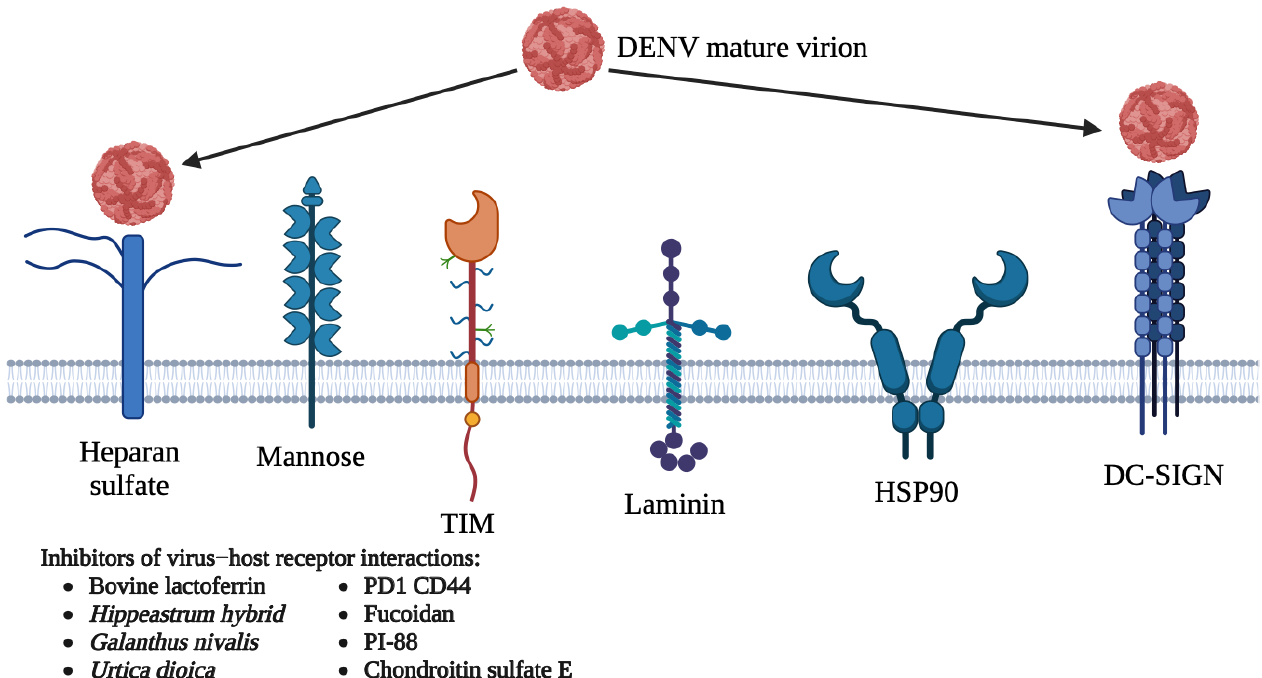
Figure 3. DENV host receptors as potential antiviral targets. Several molecules identified as possible host cellular receptors or attachment factors for DENV include heparan sulfate, mannose, DC-SIGN, laminin, HSP90/HSP70, and TIM and TAM proteins. The figure was created using Biorender.com (accessed on 26 February 2023).